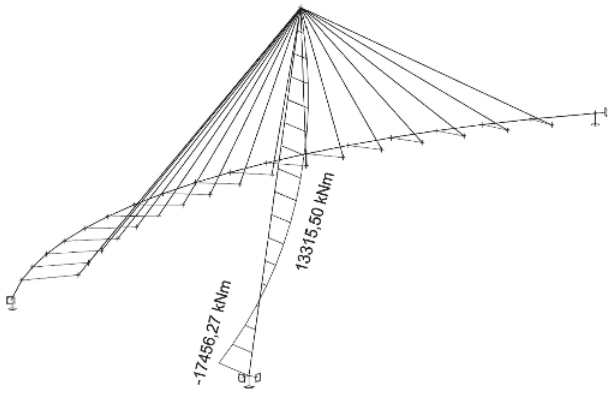
Shear force on curved deck (P+L): internal case